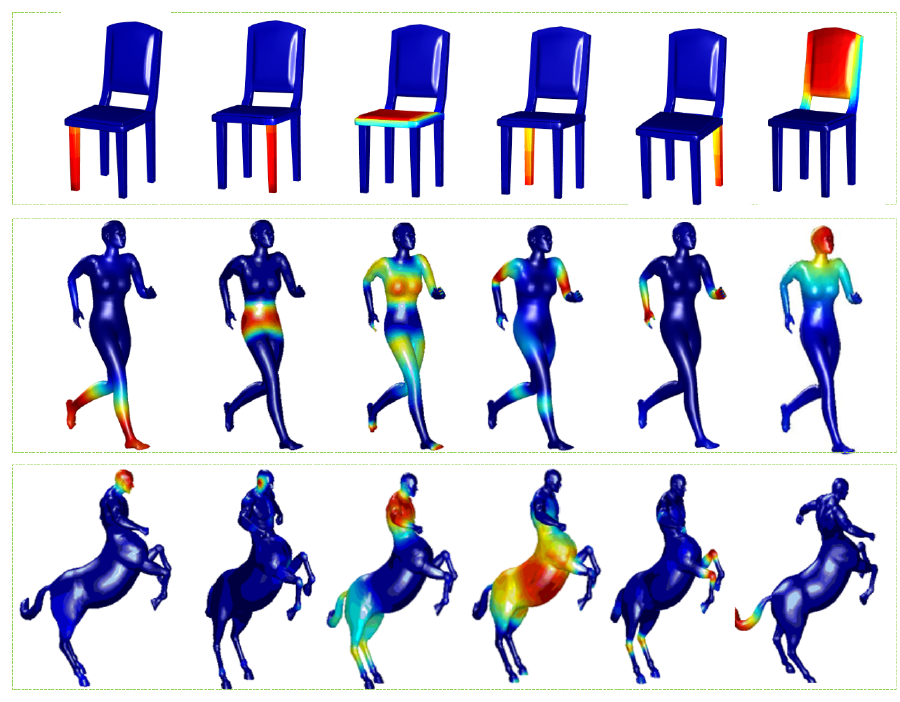
Figure 4. Visualizations of a portion of the obtained isolated hidden variables on the chair, human, and centour